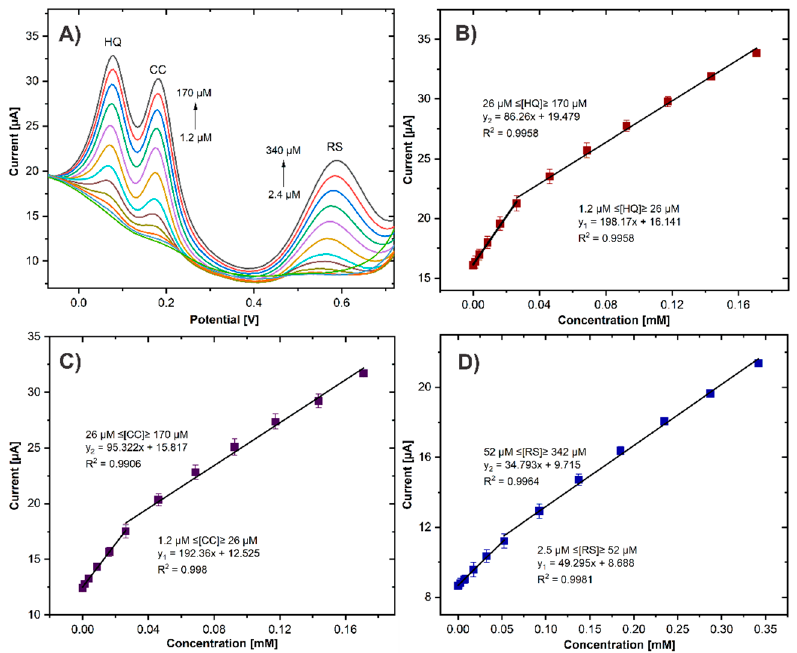
Figure 10. ( A ) DPVs of GCE/ErGO-cMWCNT/AuNPs in 0.01M PBS (pH 7.0) containing different concentrations of HQ, CC, and RS. ( B – D ): Plots of the oxidation peak currents as a function of HQ, CC, and RC concentrations, respectively.